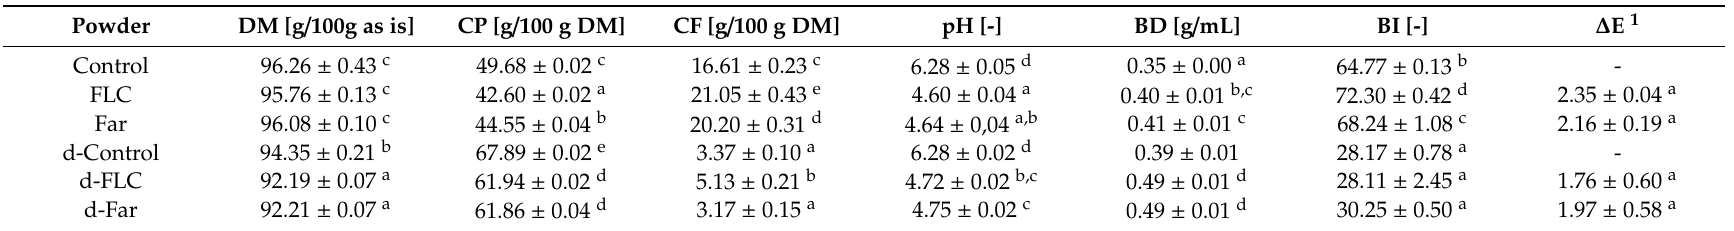
Table 1. Means ± standard deviations ( n = 3) of dry matter (DM), crude protein (CP), crude fat content (CF), pH, bulk density (BD), browning indices (BI) and total colour di ff erence with the control sample ( ∆ E) of full fat (Control and the samples fermented with Bactoferm FLC and Lactobacillus farciminis , FLC and Far) and defatted powders (d-Control and the fermented samples d-FLC and d-Far) produced from non-fermented and fermented mealworm pastes.